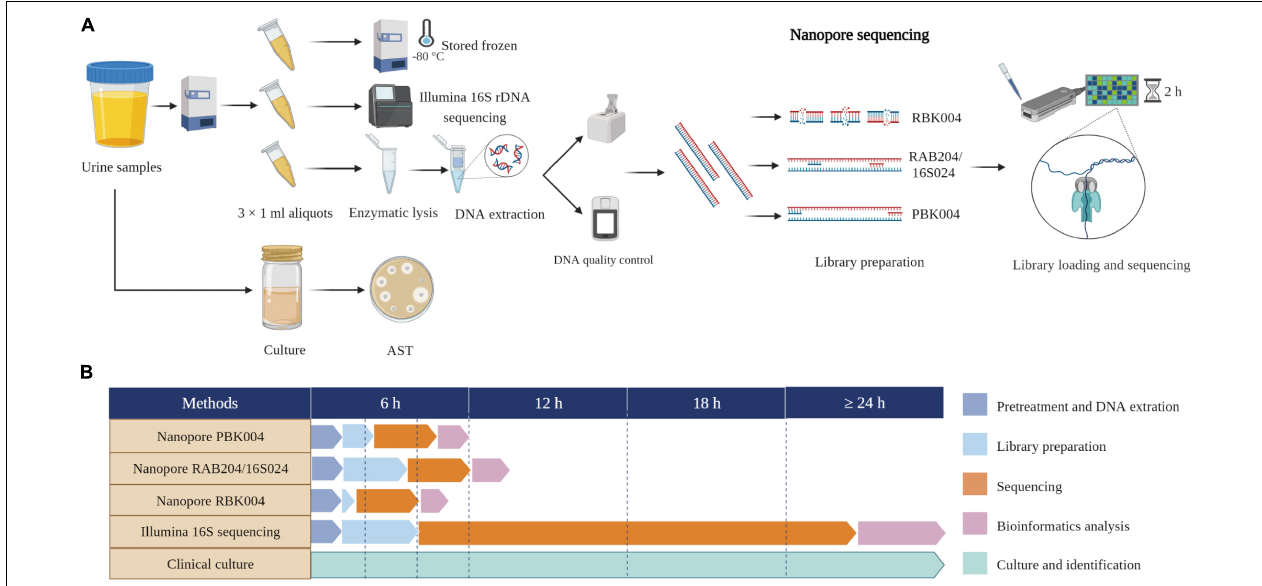
FIGURE 1 | Study workflow and time comparison. (A) Schematic of mNPS assay workflow. One aliquot performed nanopore sequencing and the other two aliquots performed Illumina 16S rDNA sequencing and stored frozen, respectively. Clinical urine culture was performed by clinical doctors. (B) Timing for mNPS testing relative to culture and Illumina sequencing. The turnaround time for sample-to-detection of mNPS testing, defined here as the cumulative time taken for sample pretreatment and DNA extraction, library preparation incorporating beads clean-up, sequencing, bioinformatics analysis, pathogen and ARGs identification, was under 6 h, while Illumina sequencing took over 24 h and culture-based pathogen identification can take days to weeks. Created with